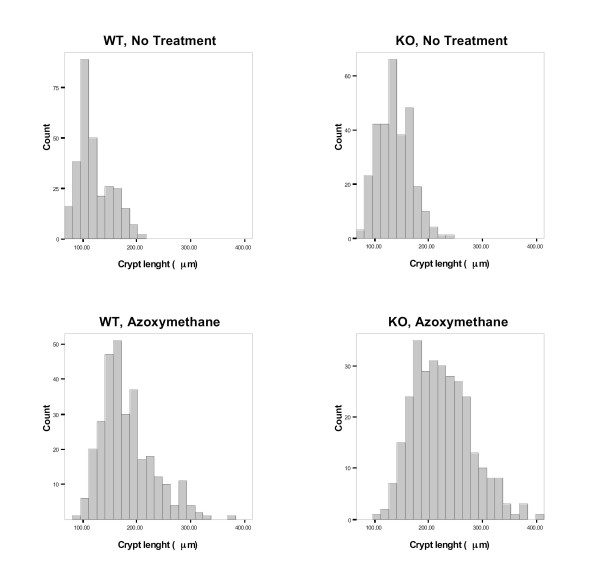
Distribution of colonic mucosal measurements in WT and KO mice. Histograms of measurements illustrate distribution of crypt length in wild type and CyCAP-/- animals.